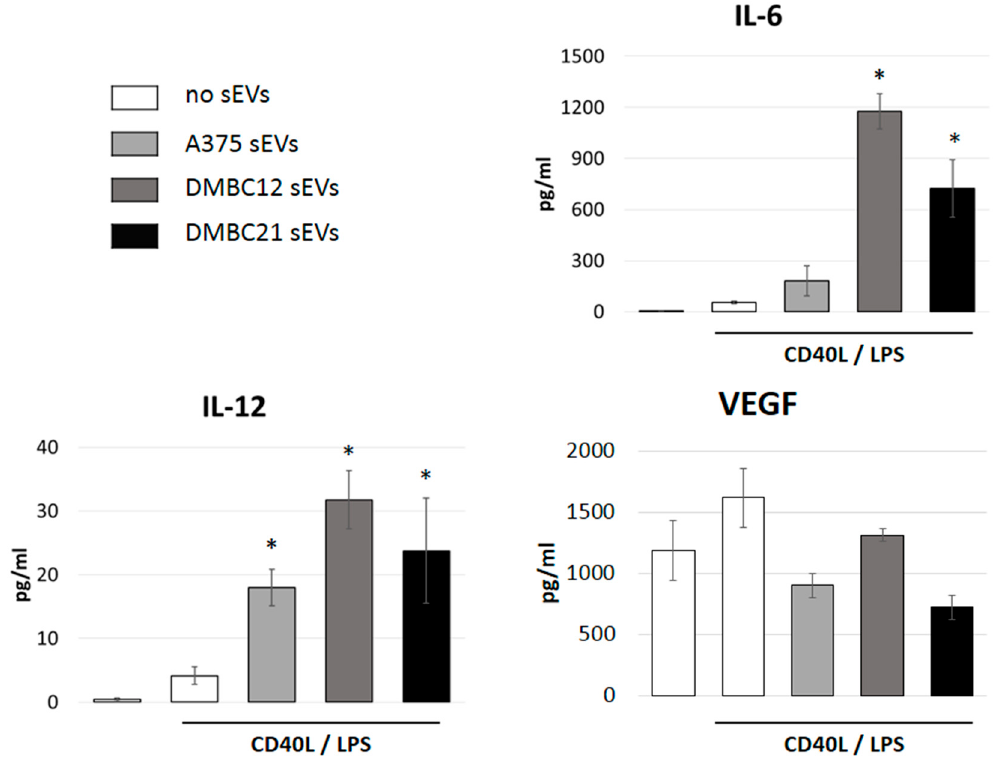
Figure 4. sEVs affect the cytokine secretion of APCs. THP-1 DC cells were stimulated to secrete cytokines by incubation with LPS and CD40L. The addition of melanoma cell-derived sEVs (A375, DMBC12 or DMBC21) increased the expression levels of IL-12 and IL-6, while secretion of VEGF was less affected. Mean values and standard deviations are shown from three independent experiments. Significant differences in the presence versus absence of sEVs are marked with asterisks.